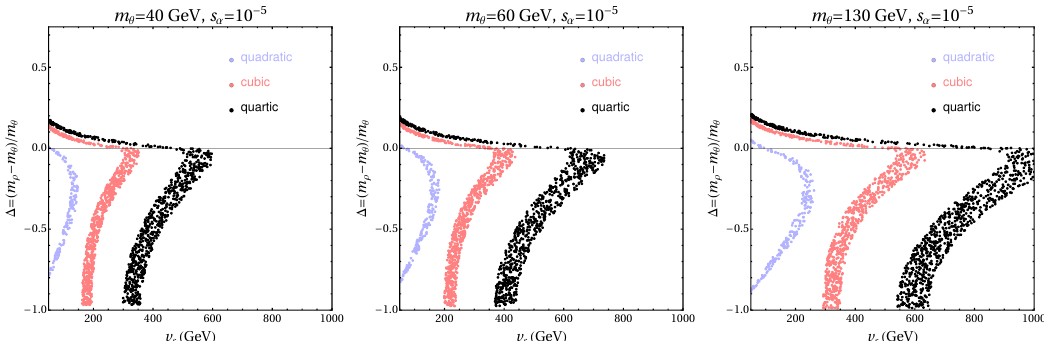
Figure 7. Scan in ∆ and v s for fixed values of m θ and s α . The points fulfill the condition 0 . 5 6 Ω / Ω 6 1 . We also impose the XENON1T and the invisible Higgs decay constraints. The obs same color code as in figure 4 is